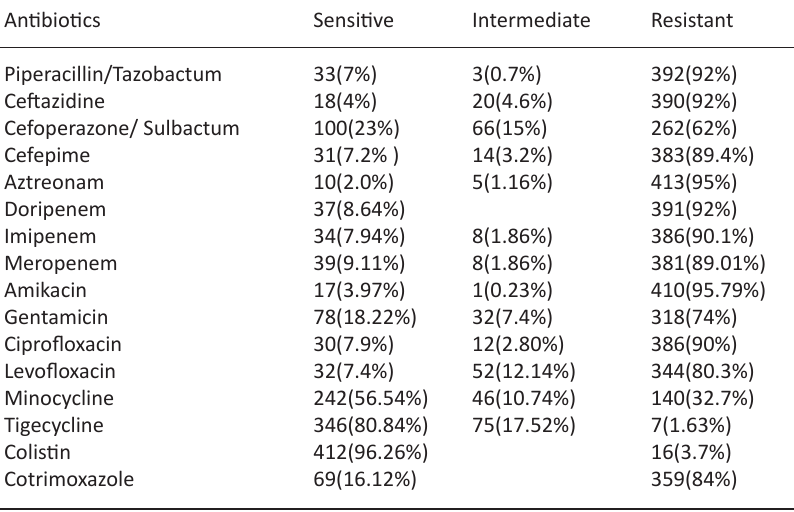
Table 3. showing Antibiotic resistance pattern of Pseudomonas Antibiotics